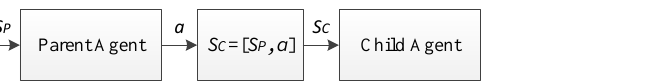
Figure 8. Progression from parent agent to child agent. Reprinted with permission from [26]. 2018, Peng.